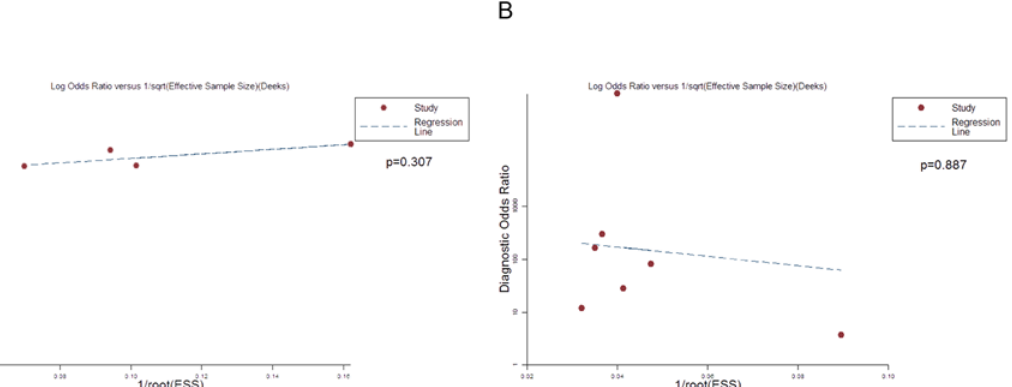
Fig 6. Probabilities of CTEPH after CT on a patient-based level. The plot showed that CT has a favorable positive post-test probability over a wide range of pre-test probabilities, which can be applied to rule in